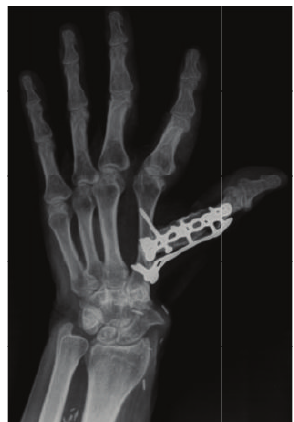
Figure 3: Postoperative X-ray of the left hand demonstrating fusion of the proximal phalanx of the thumb to the second metacarpal.